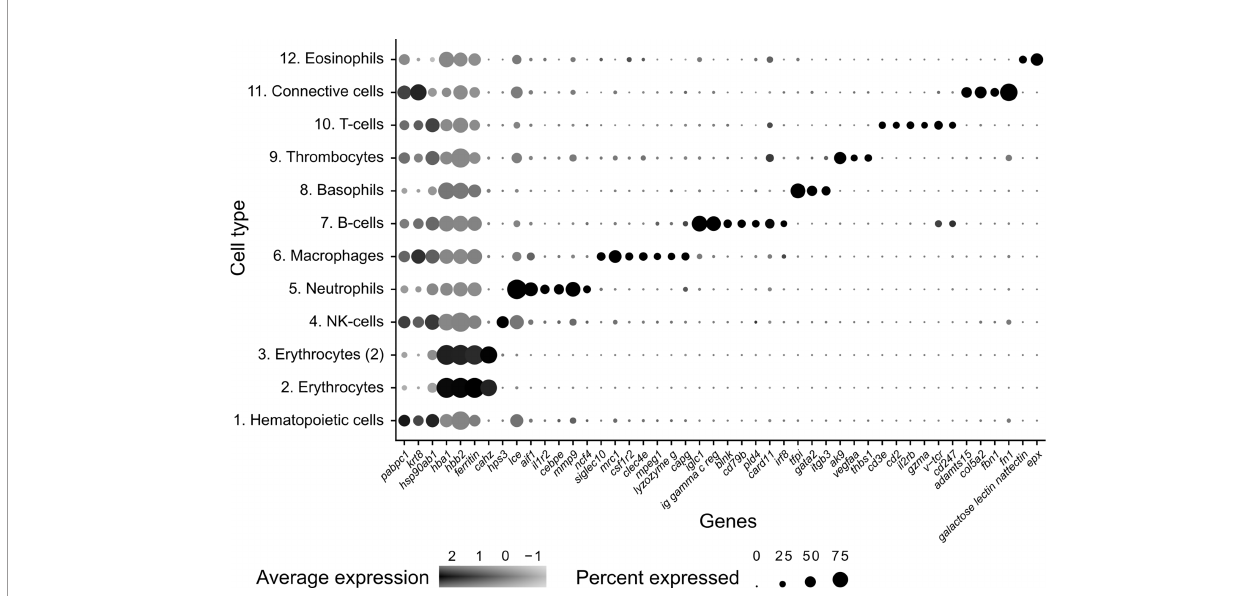
FIGURE 2 | Dot plot visualization of deduced cell markers used to de fi ne cell clusters in Syngnathus typhle . Dot size denotes the percentage of cells expressing the gene within each cluster and the mean expression level of active expressional cells is indicated by the color